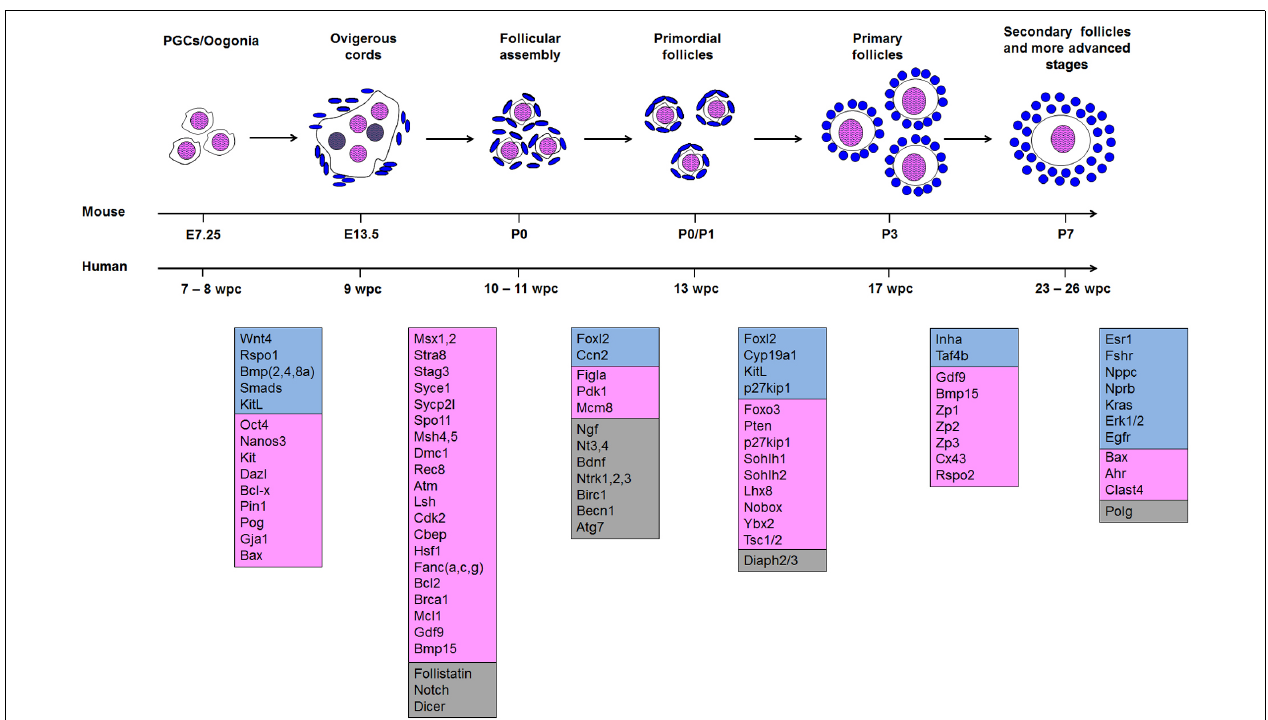
FIGURE 1 | Morphogenesis of follicles from the arrival of primordial germ cells (PGC) in the nascent ovary to secondary follicles. Genes assigned to each transition are as specified in the text. Somatic genes are shown in blue; germ cell genes are shown in pink; and genes that are either expressed in both or whose site of expression has not been assigned are in gray. In the ovigerous cord, oocytes that are lost and do not form primordial follicles are colored